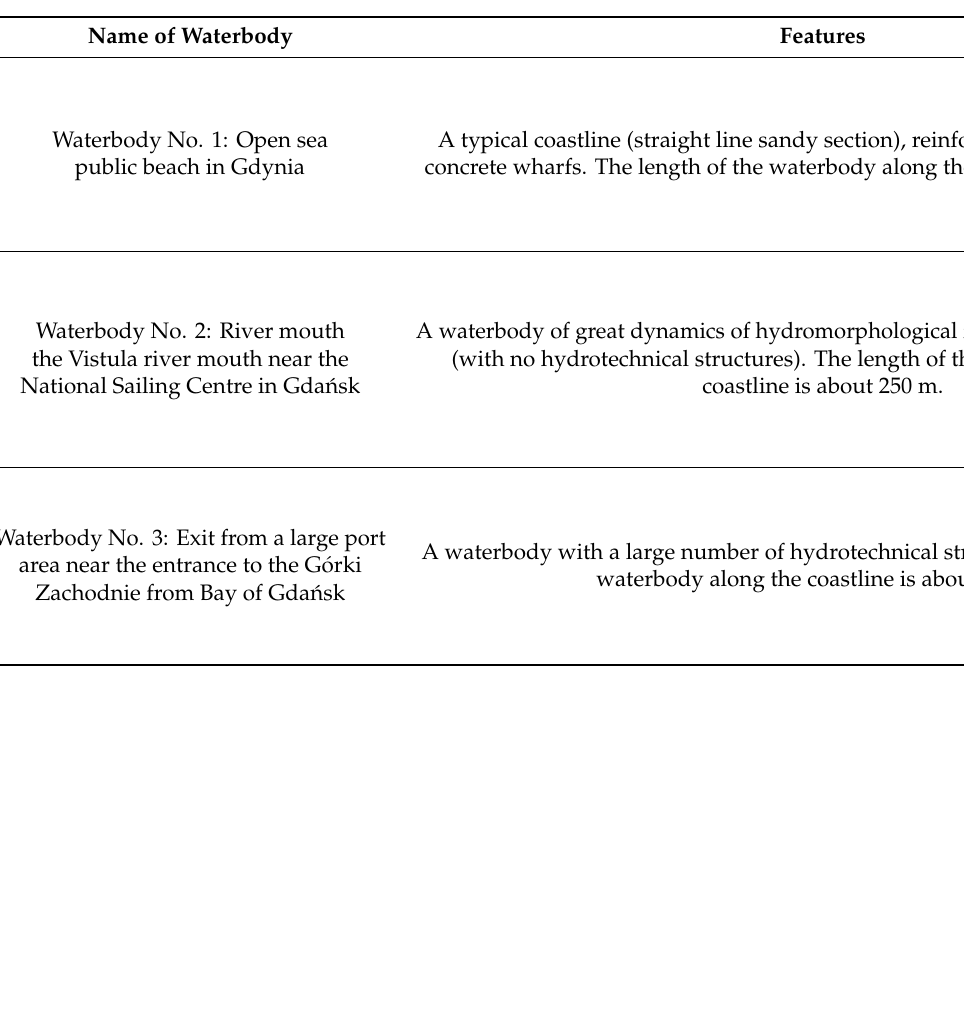
Table 2. Representative waterbodies where measurements of the territorial sea baseline were conducted. Own study based on [18].